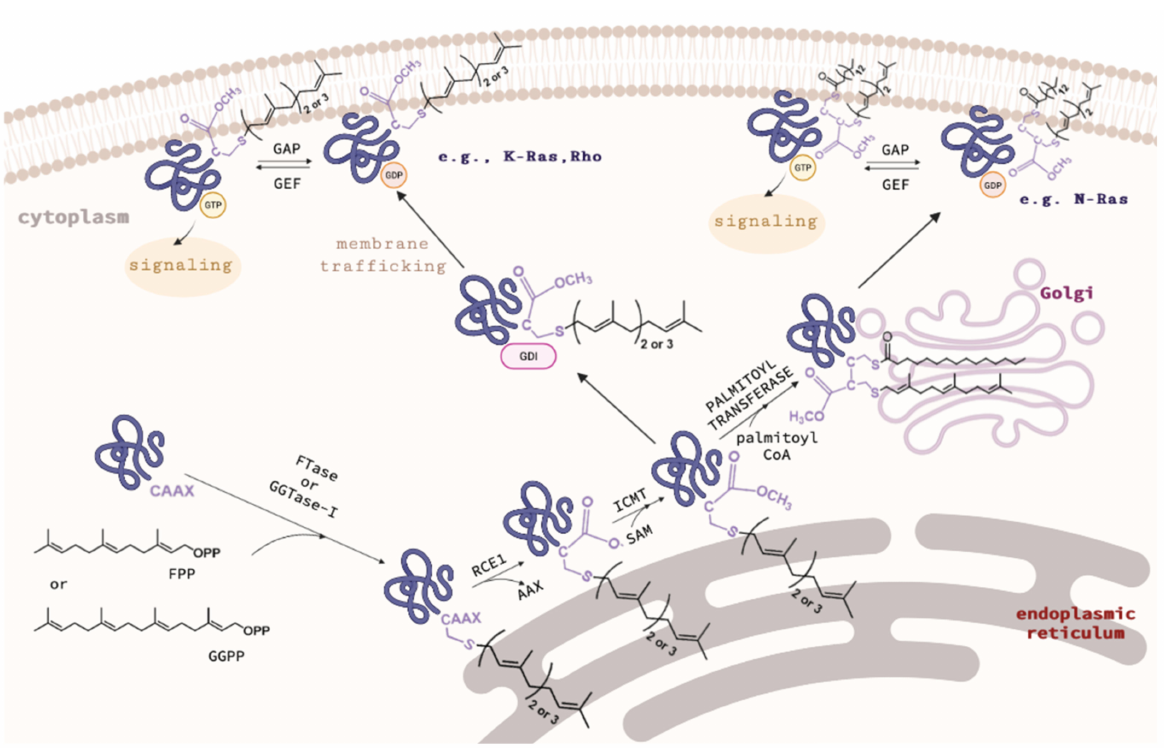
Figure 1. Processing pathway of CAAX prenyltransferases (created in BioRender.com). The CAAX proteins are synthesized in a soluble form and then modified by protein prenyltransferase, FTase, or GGTase-I. Further processing by RCE1 and ICMT generates mature forms of S-prenylated proteins targeted and anchored to the appropriate membranes. In some cases, S-palmitoylation is necessary to immobilize proteins in membranes